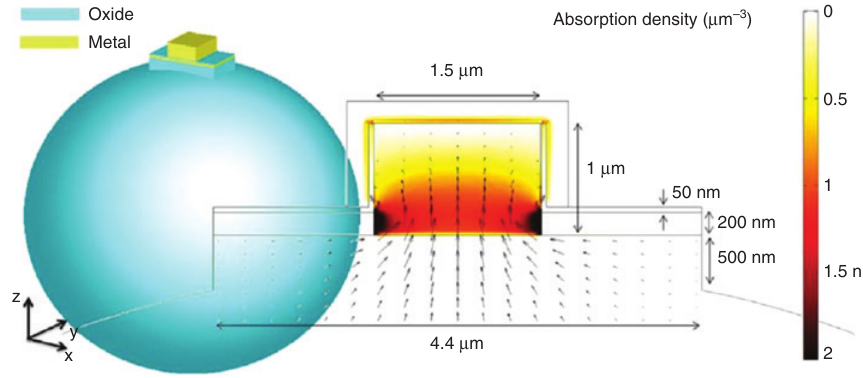
Figure 16: Schematic of the hybrid antenna and FDTD simulation cross-sectional view of the metallo-dielectric micro cavity. The right figure shows the optical power flow (arrows) and normalized power consumption density (optical absorption density) throughout the cavity at the operating wavelength λ ~ 8 μ m